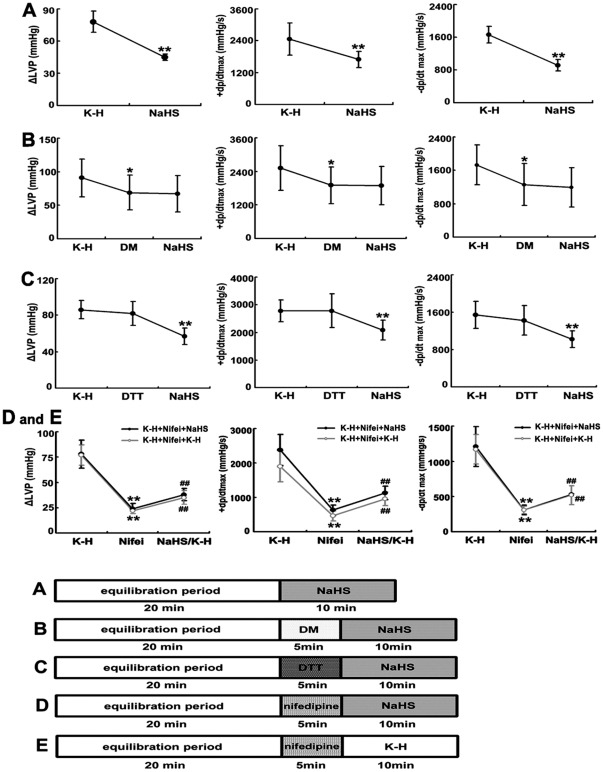
NaHS and sulfhydryl modifiers impacted NaHS-induced cardiac function.A: NaHS (100 µmol/L) depressed LV ± dp/dtmax and ΔLVP significantly as compared with the control. **
P<0.01 vs. control. B: NaHS (100 µmol/L) could not change LV ± dp/dtmax and ΔLVP in the presence of DM perfusion. *
P<0.05 vs. control, #
P<0.05 vs. DM. C: NaHS (100 µmol/L) could depress LV ± dp/dtmax and ΔLVP in the presence of DTT. **P<0.01 vs. DTT group. D and E: There were no significant differences in the change in the ventricular ±dp/dtmax and ΔLVP between the perfusate with and without NaHS following nifedipine perfusion (P>0.05). The gray line stands for the experiment protocol “K-H +Nifei+K-H”, and the black line stands for the experimental protocol “K-H +Nifei+NaHS”. **
P<0.01 vs control group. ##
P<0.01 vs. nifedipine group.